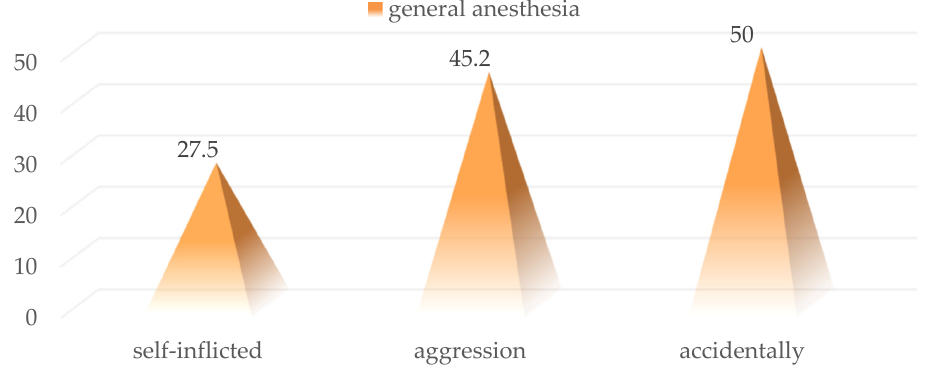
Figure 6. Epidemiological characteristics of patients with surgical exploration performed under general anesthesia.